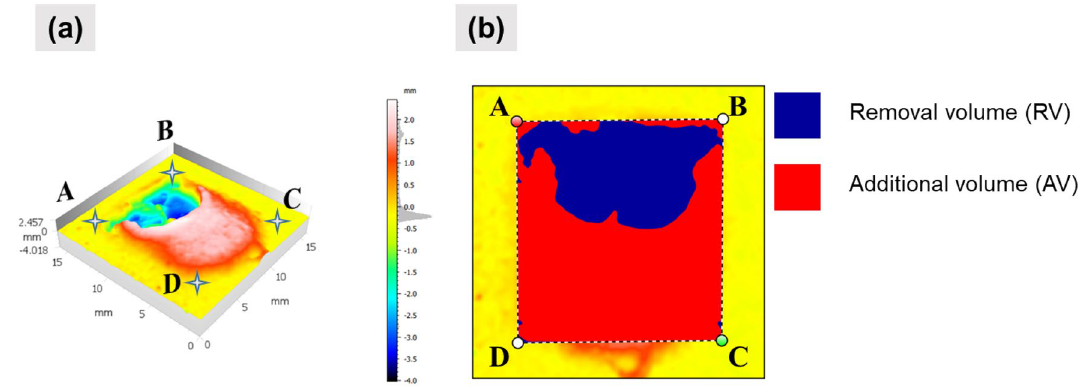
Figure 7. ( a ) UHPC-2 at scanning speed of 5 mm/s 3D Topography surface images, ( b ) RV and AV